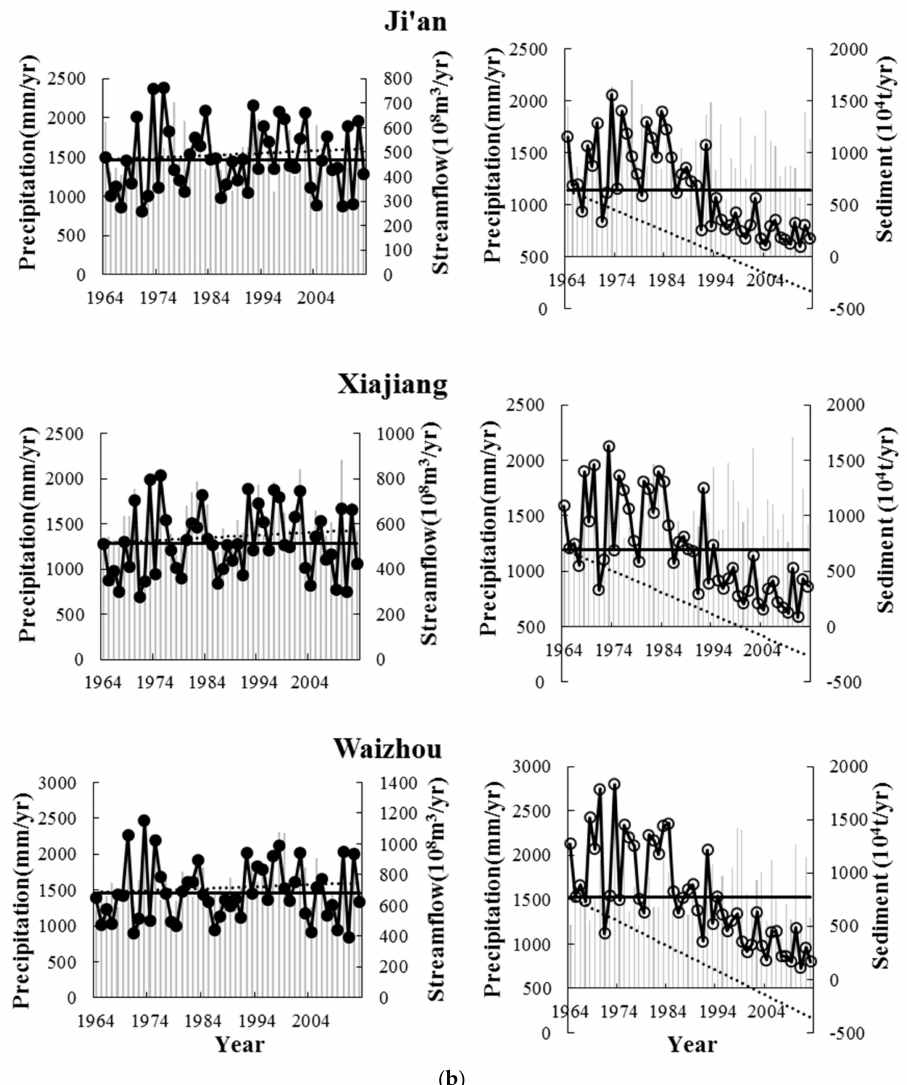
Figure 2. ( a ) Observed annual hydro-meteorological variables in the upstream of Ganjiang River basin. ( b ) Observed annual hydro-meteorological variables in the midstream and downstream of Ganjiang River basin. Note: The solid and hollow markers represent annual streamflow and sediment discharge, respectively. The horizontal solid and dashed lines are the mean values and trend lines,